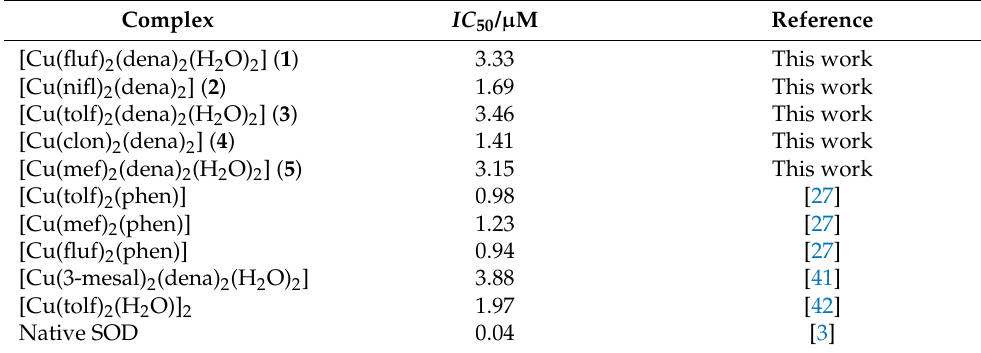
Table 4. SOD mimetic activity of selected copper NSAIDs.